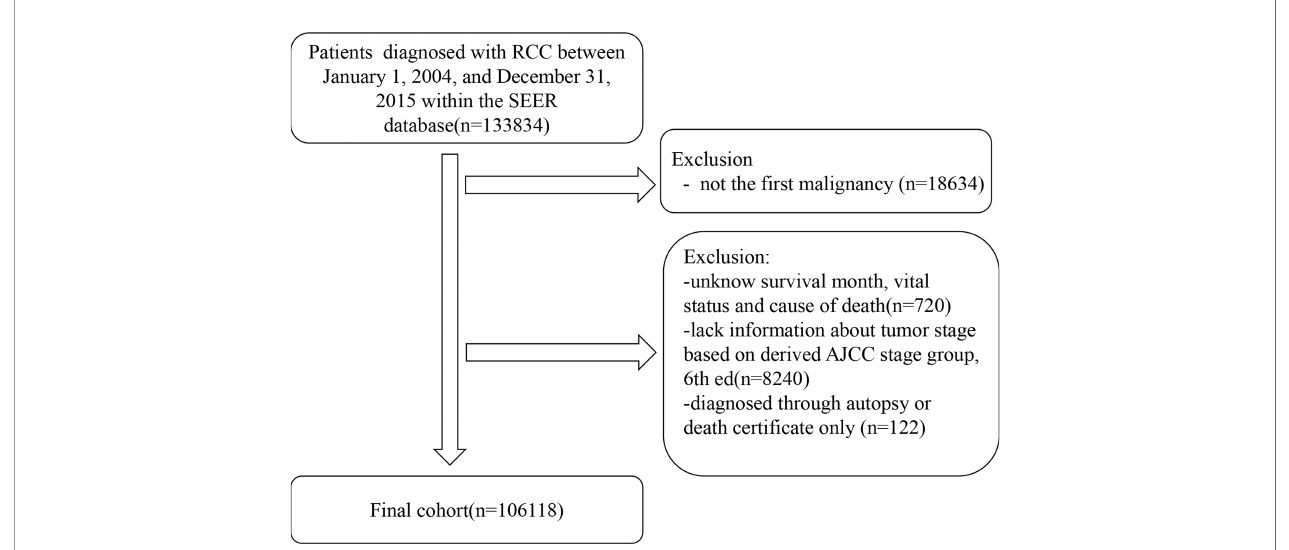
FIGURE 1 | Flowchart of participant